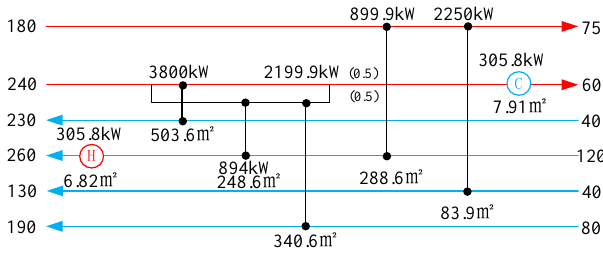
Figure 5. Solution of case 2 obtained by NNM model with serial structures; the TAC is 112,301 $ / a. Table 4. Comparison results of case 2.